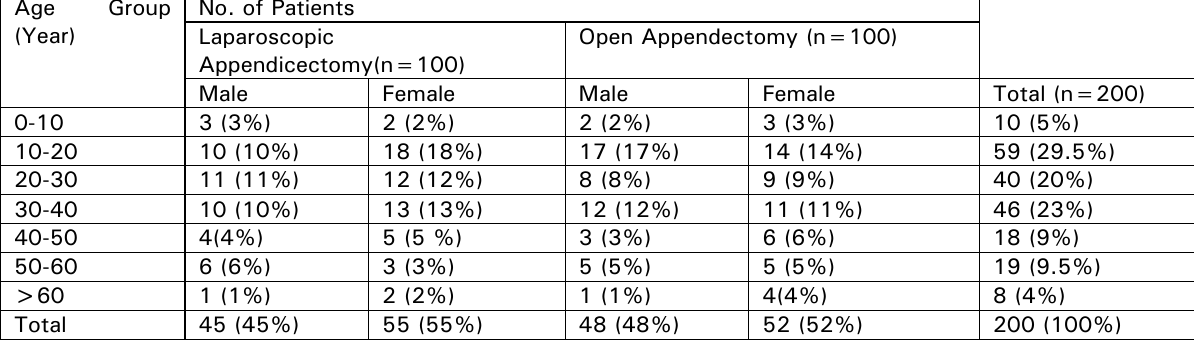
Table 2: Distribution of patients according to different age groups